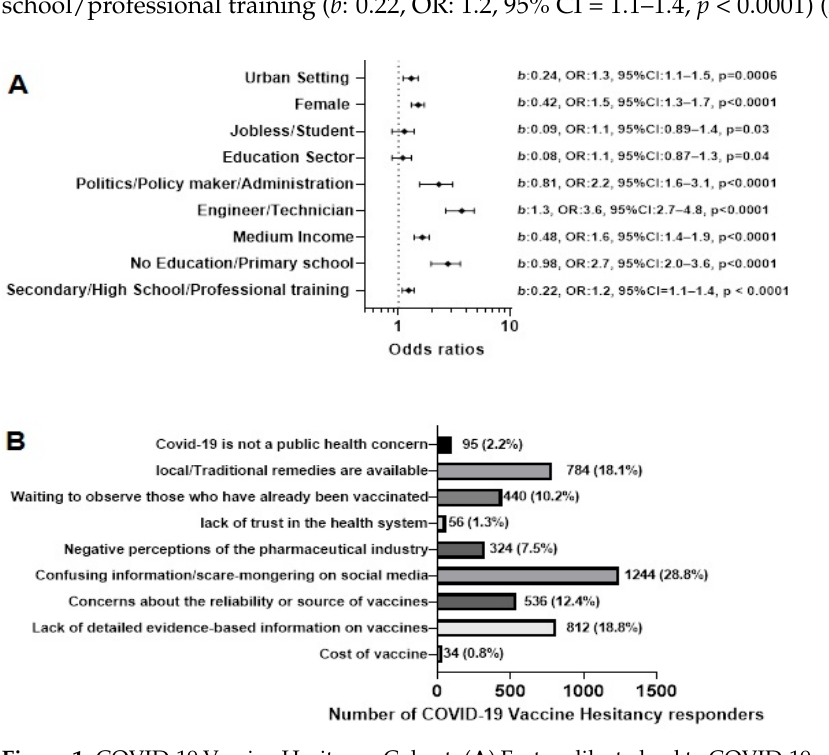
Figure 1. COVID-19 Vaccine Hesitancy Cohort. ( A ) Factors like to lead to COVID-19 vaccine hesitancy using multiple logistics regression. ( B ) The number of reasons for vaccine hesitancy and how many COVID-19 vaccine hesitant persons chose each reason. The different bar colours represent the different options for the participants.